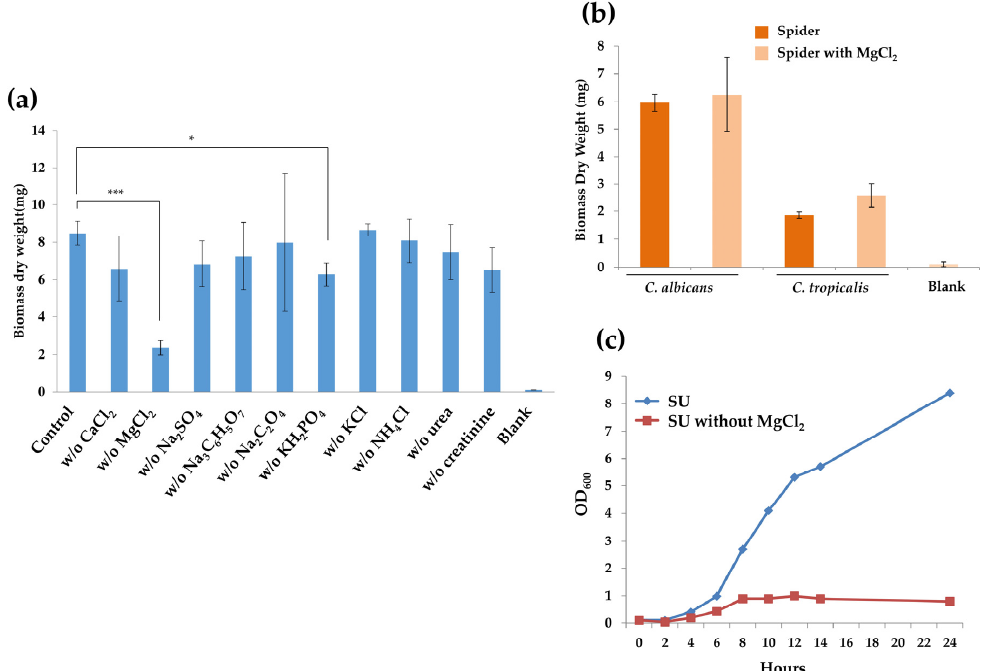
Figure 4. Effects of the ingredients of SU on biofilm formation in C. tropicalis : ( a ) Depletion of MgCl 2 or KH 2 PO 4 in SU significantly inhibited biofilm formation. ( b ) The addition of exogenous MgCl 2 in Spider medium caused very only slight effects on biofilm dry weights in both C. albicans and C. tropicalis . Values are the mean ± SD from five replicates. * p < 0.05; *** p < 0.001. ( c ) Growth curves of C. tropicalis strains at 30 °C in SU with or without additional MgCl 2 showed the requirement of magnesium for C. tropicalis proliferation. Growth rates were monitored every 2 h using a Biowave density meter.